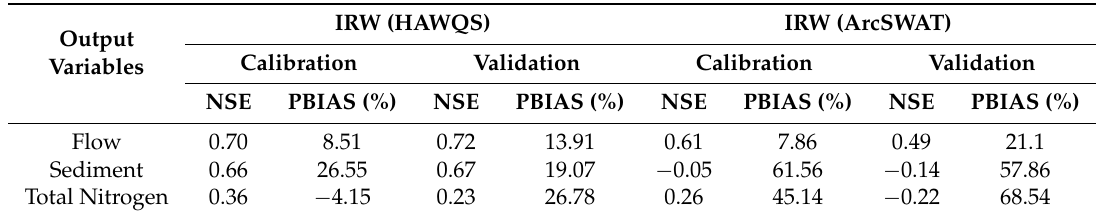
Table 1. Error statistics for monthly flow, sediment and total nitrogen (TN) for calibration (1983–1989) and validation (1990–2001) periods.